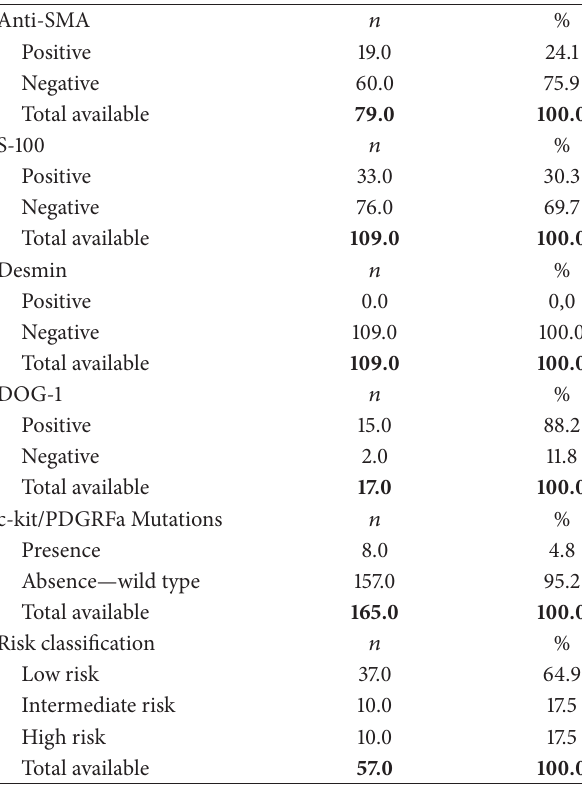
Table 2: Clinical and pathological features from 252 GISTs in 126 NF1